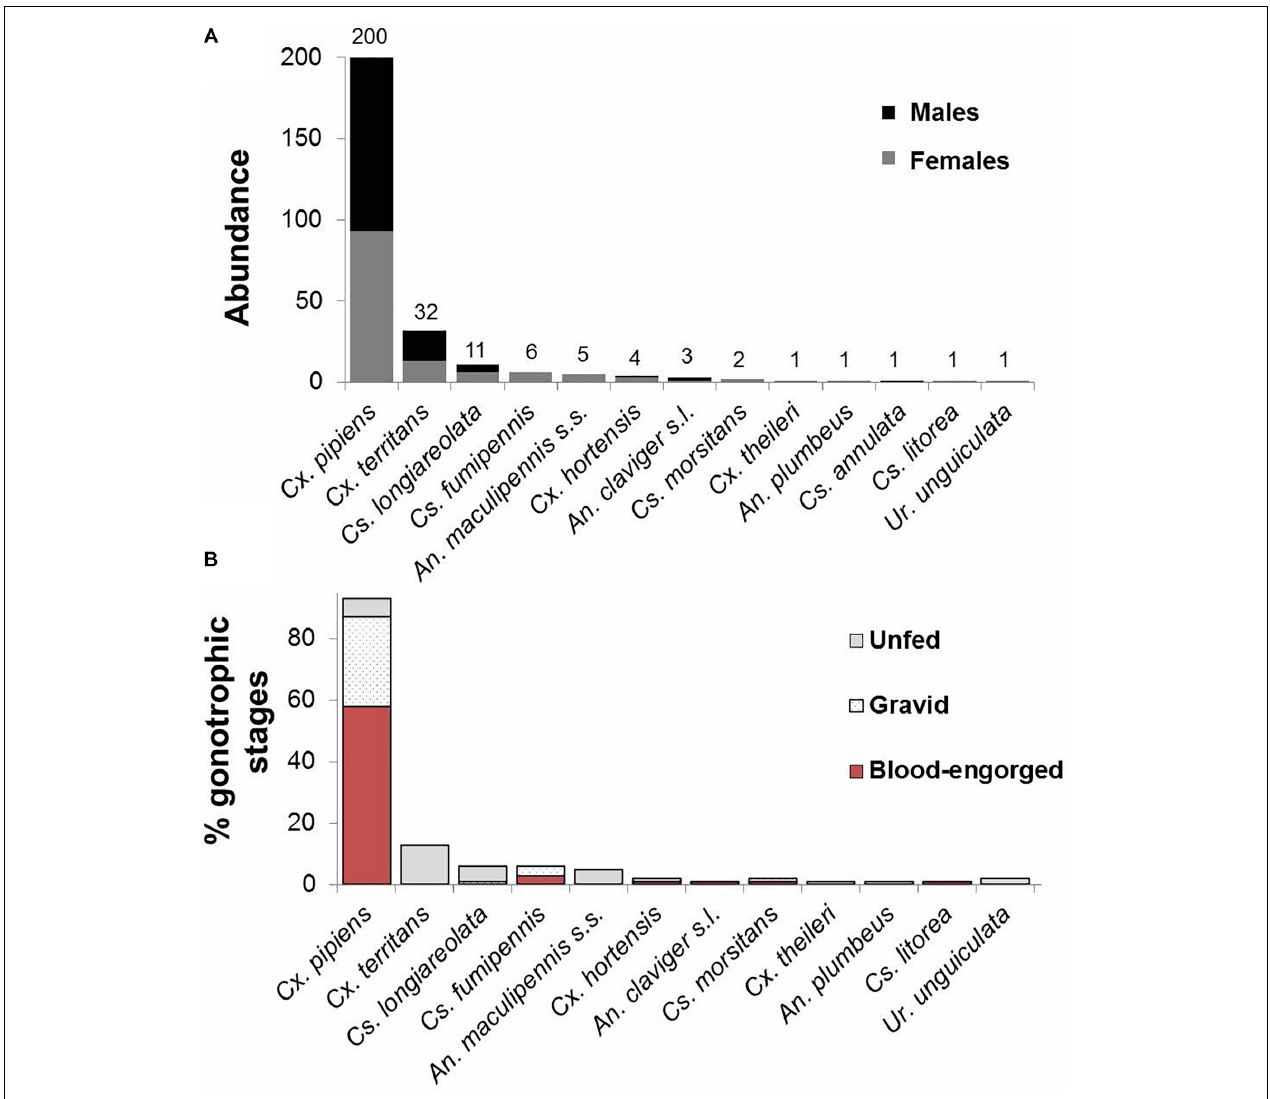
FIGURE 2 | Catches of mosquito species recorded from all the sampling settings. (A) Males and females. (B) Gonotrophic stages of females.